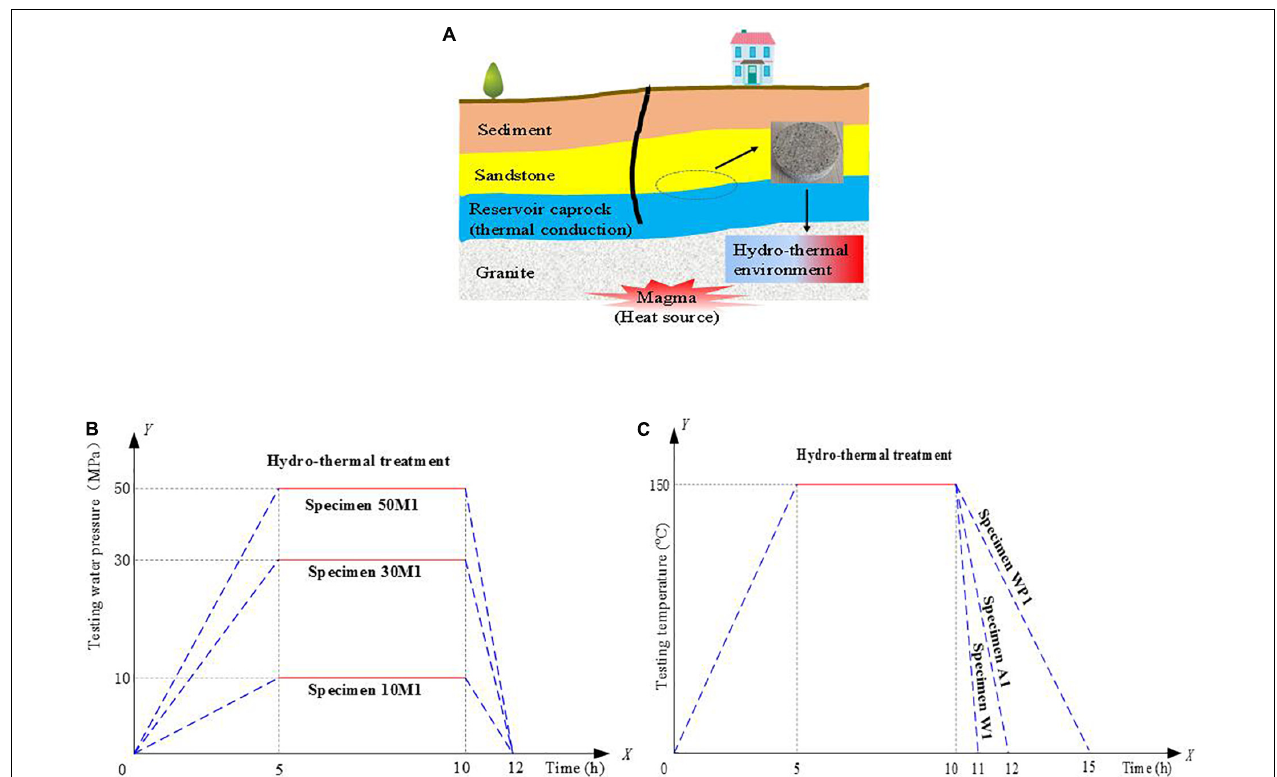
FIGURE 2 | Experimental background and project: (A) schematic diagram of deep rock environment; (B) schedule of hydro-thermal treatment; (C) schedule of cool down